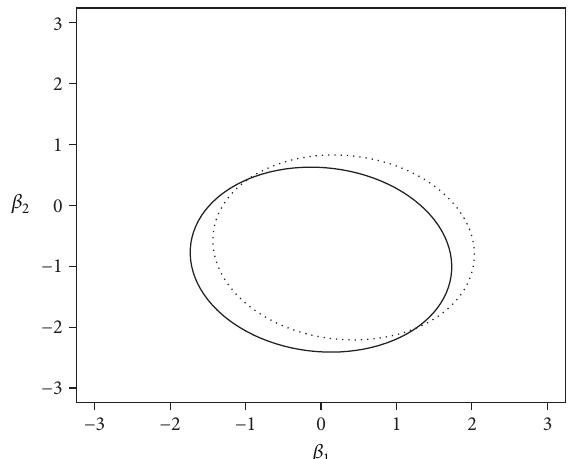
Figure 5: The 0.95 confidence regions for the regression coefficients 𝛽 𝛽 1 and 2 with correlation structures being independence (dotted curve) and first-autoregressive (sold